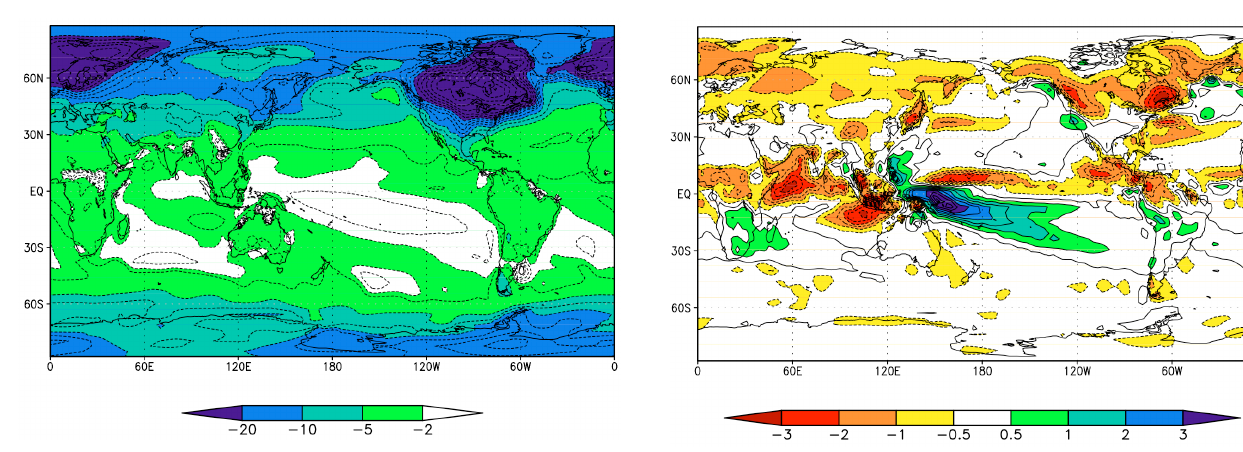
Fig. 11. The change in annual mean precipitation LGM-PI (mmday − 1 Figure 11. The change in annual mean precipitation LGM-PI (mm/day). 3 4